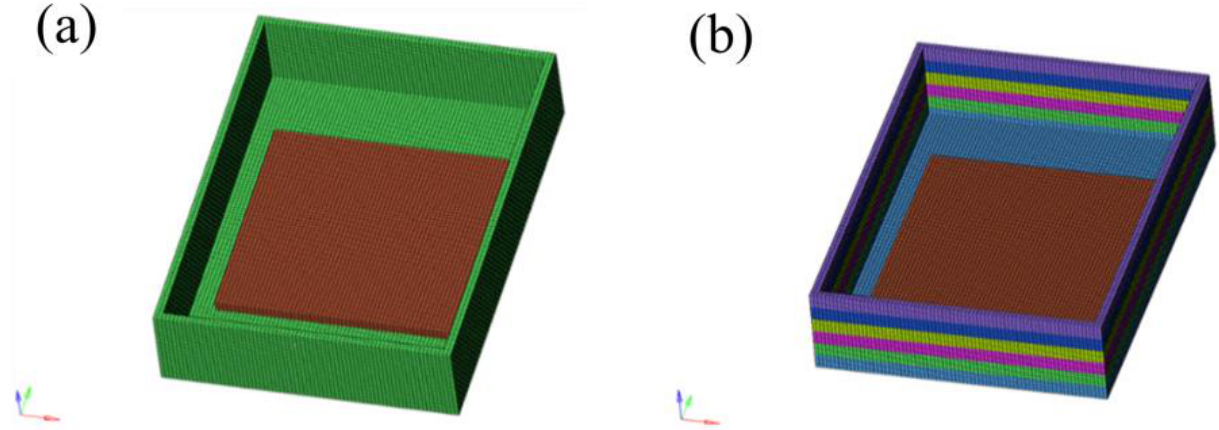
Figure 12. The simulated package cover in a T/R component: ( a ) 6061 Al; ( b ) gradient AlN/Al composite; different colours refer to different AlN/Al composites.